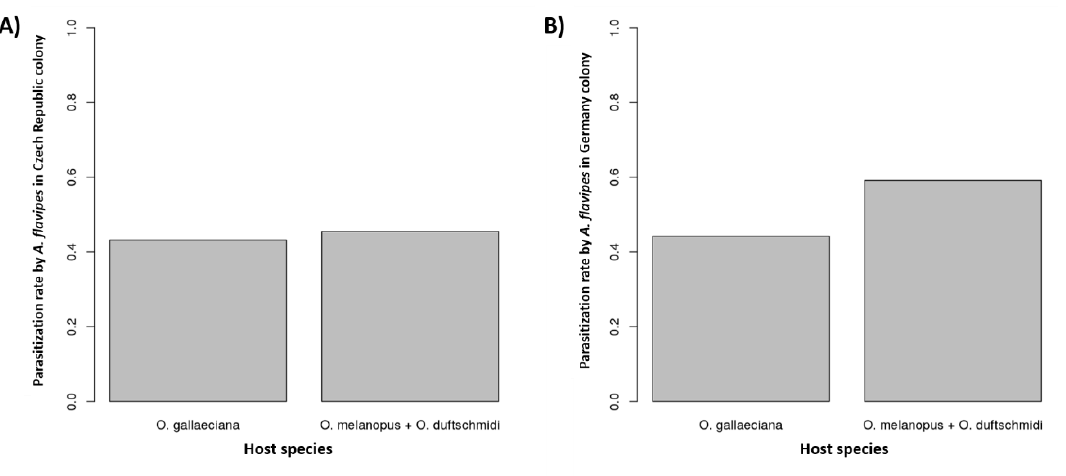
Figure 5. The graphs show the proportion of parasitized host eggs by A. flavipes wasps from localities, 216 where the host defense (host eggs with dark sticky layer) was observed—Czech Republic ( A ), and the 217 localities without host defense—Germany ( B ). 218